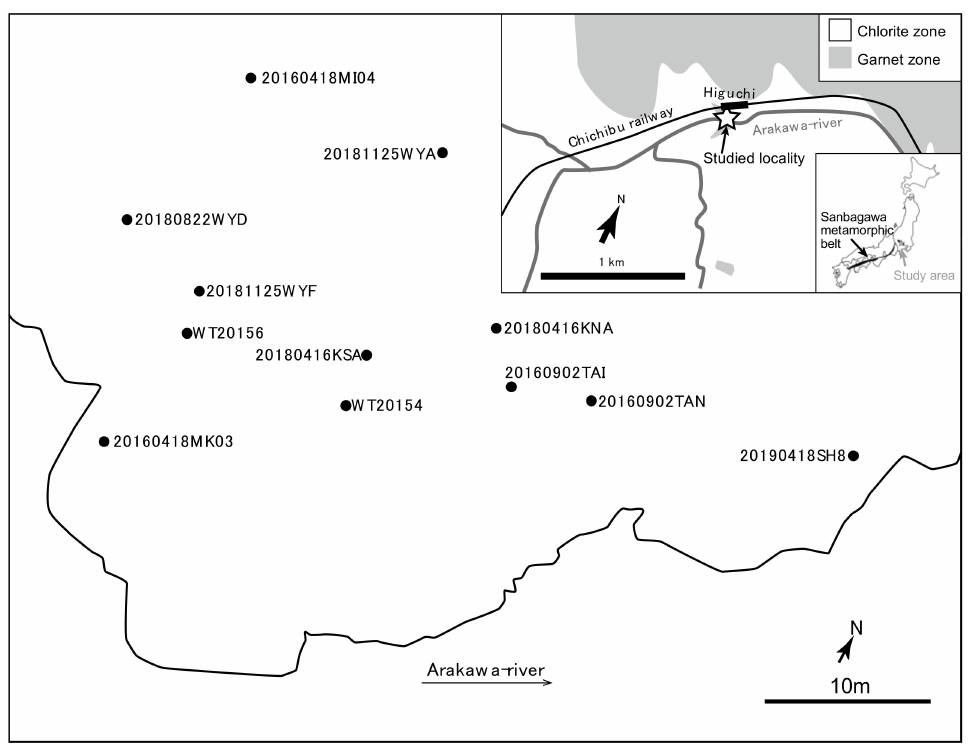
Figure 1. Locality map of this study. Modified after Hashimoto et al. [20]. Chlorite zone is the Zone I in [20] which is the lowest grade zone. Garnet appears in the Garnet zone (Zone II in